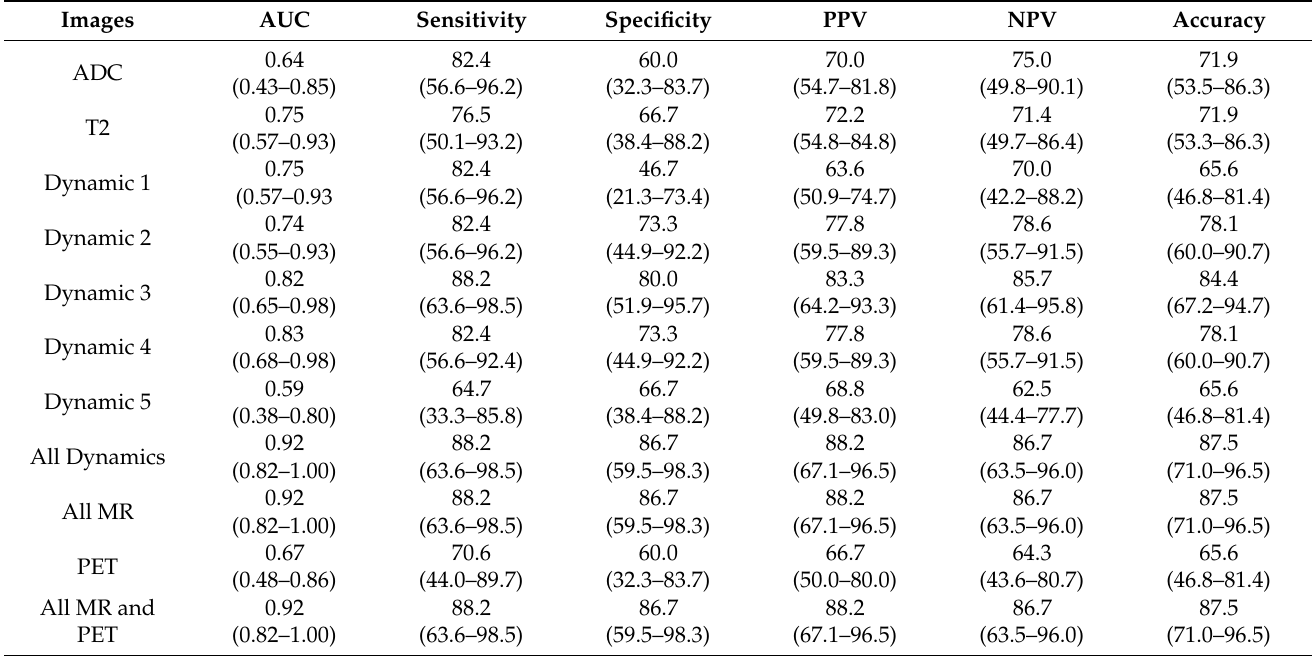
Table 4. Best mean classification accuracies achieved for prediction of pCR based on each MRI imaging sequence as well as in combination with PET for prediction of pCR in